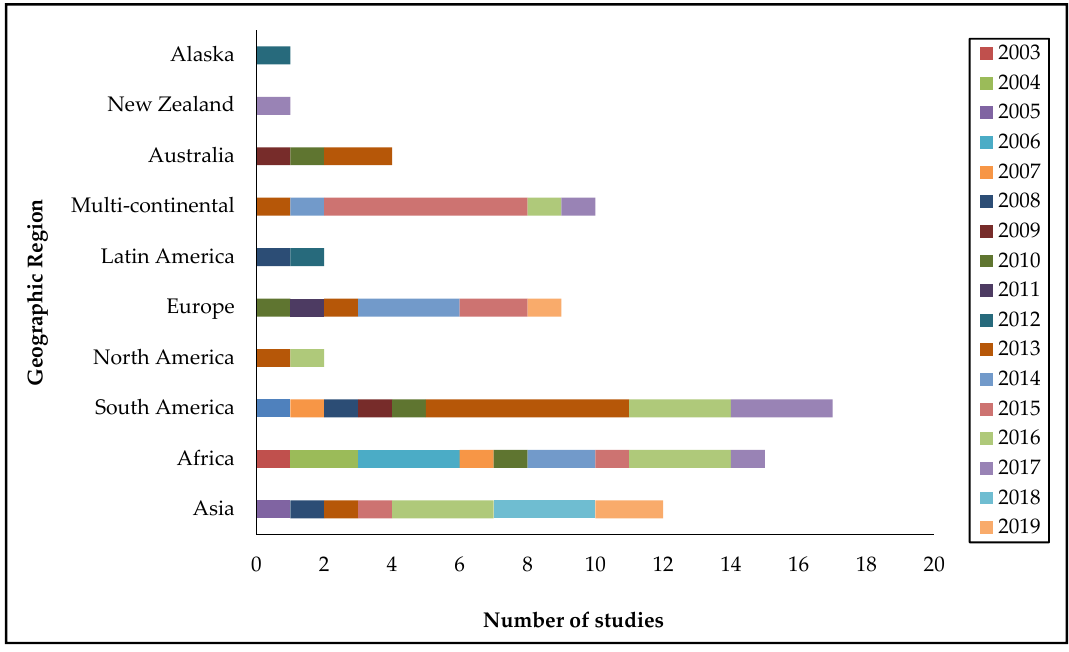
Figure 2. Number of studies per geographic region according to their year of publication.